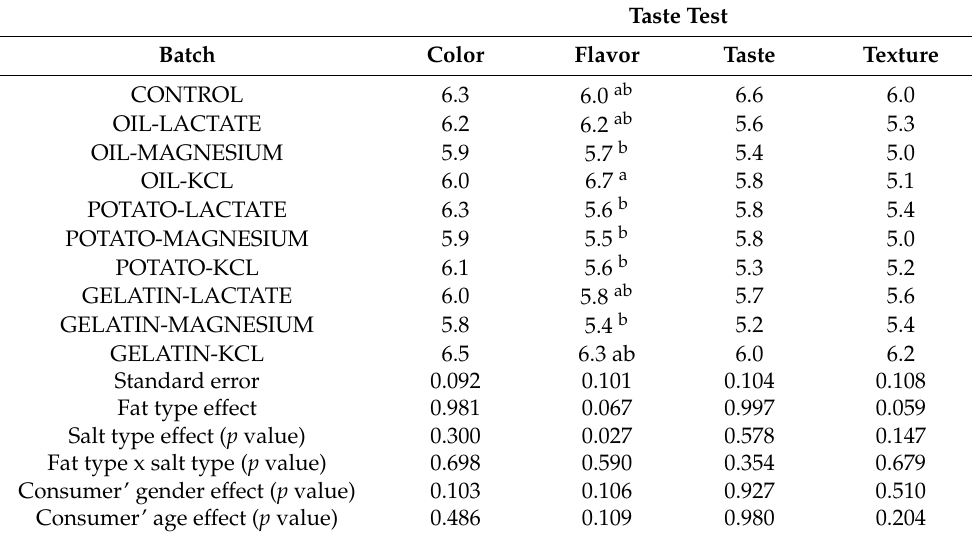
Table 6. The means and standard error for scores (1–10) in a taste test of 10 experimental batches of dry-fermented sausages. p -values for salt type and fat type effects and for consumer’ gender and age